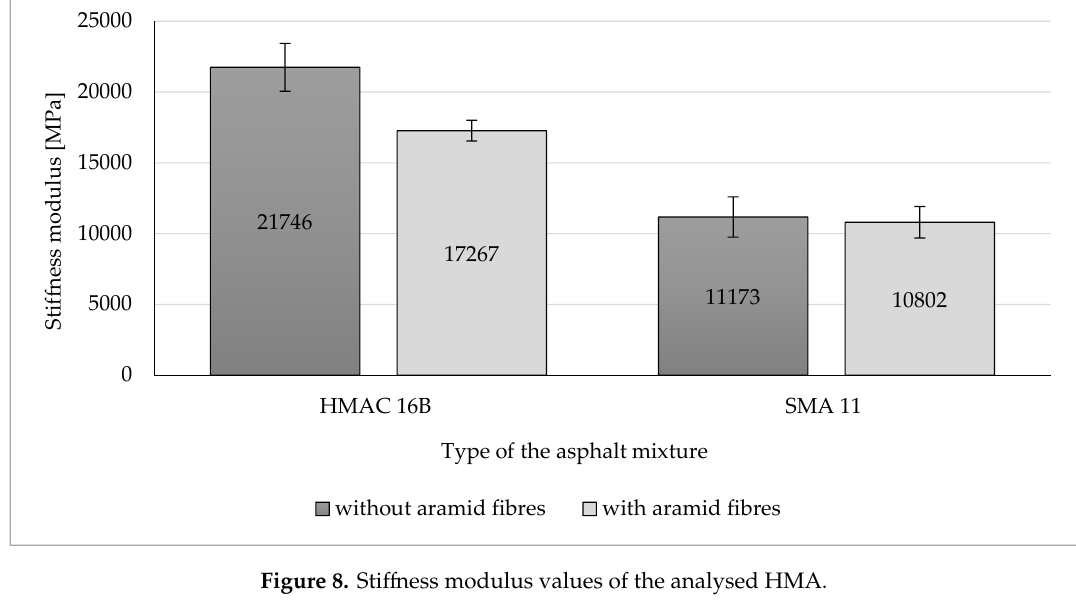
Figure 8. Stiffness modulus values of the analysed HMA. Figure 8. Sti ff ness modulus values of the analysed HMA. Materials 2020 , 13 , x FOR PEER REVIEW